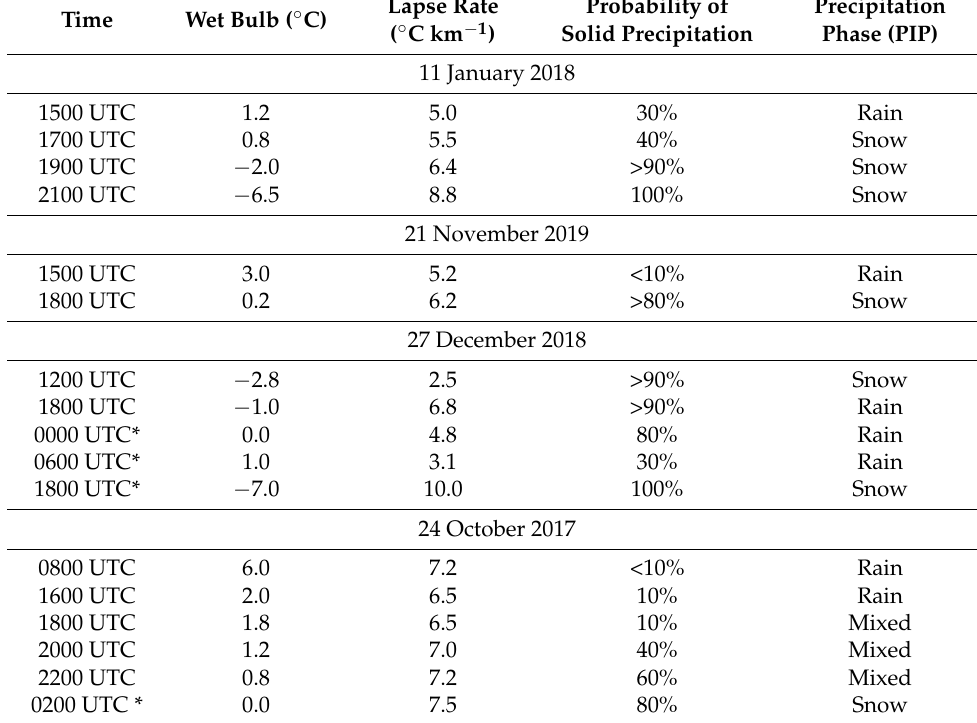
Table 4. Select times within each event with calculated wet bulb temperature (WBT) from surface observations and lapse rate (LR) from ERA5 reanalysis profiles. The WBT and LR are used to find a probability of solid precipitation via Sims and Liu [20] and compare to the precipitation phase as determined by the PIP. * Denotes +1 day UTC from start date. Lapse Rate Probability of Time Wet Bulb ( ◦ C) ( ◦ C km − 1 ) Solid Precipitation